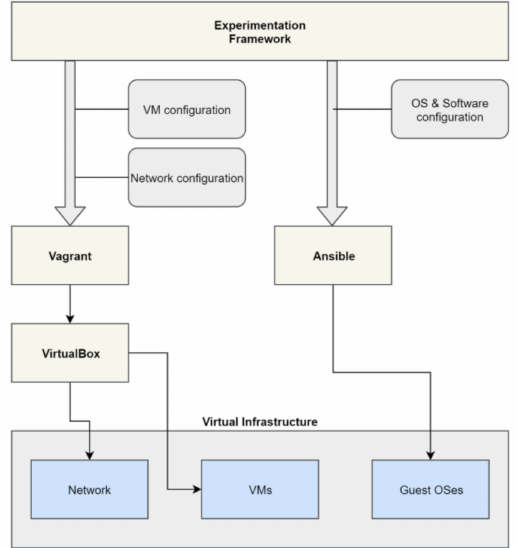
Figure 1. Scheme of the virtual bench for obtaining experimental evaluations of the integration of information technology